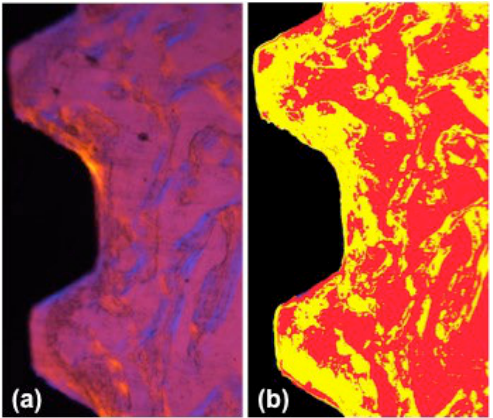
Figure 3. Image segmentation of the original picture. ( a ). Polarized image of the interface area; ( b ). Image segmentation with Image ProPlus, showing the implant (black), connective tissue (red), and newly formed bone (yellow). Magnification: 10×.